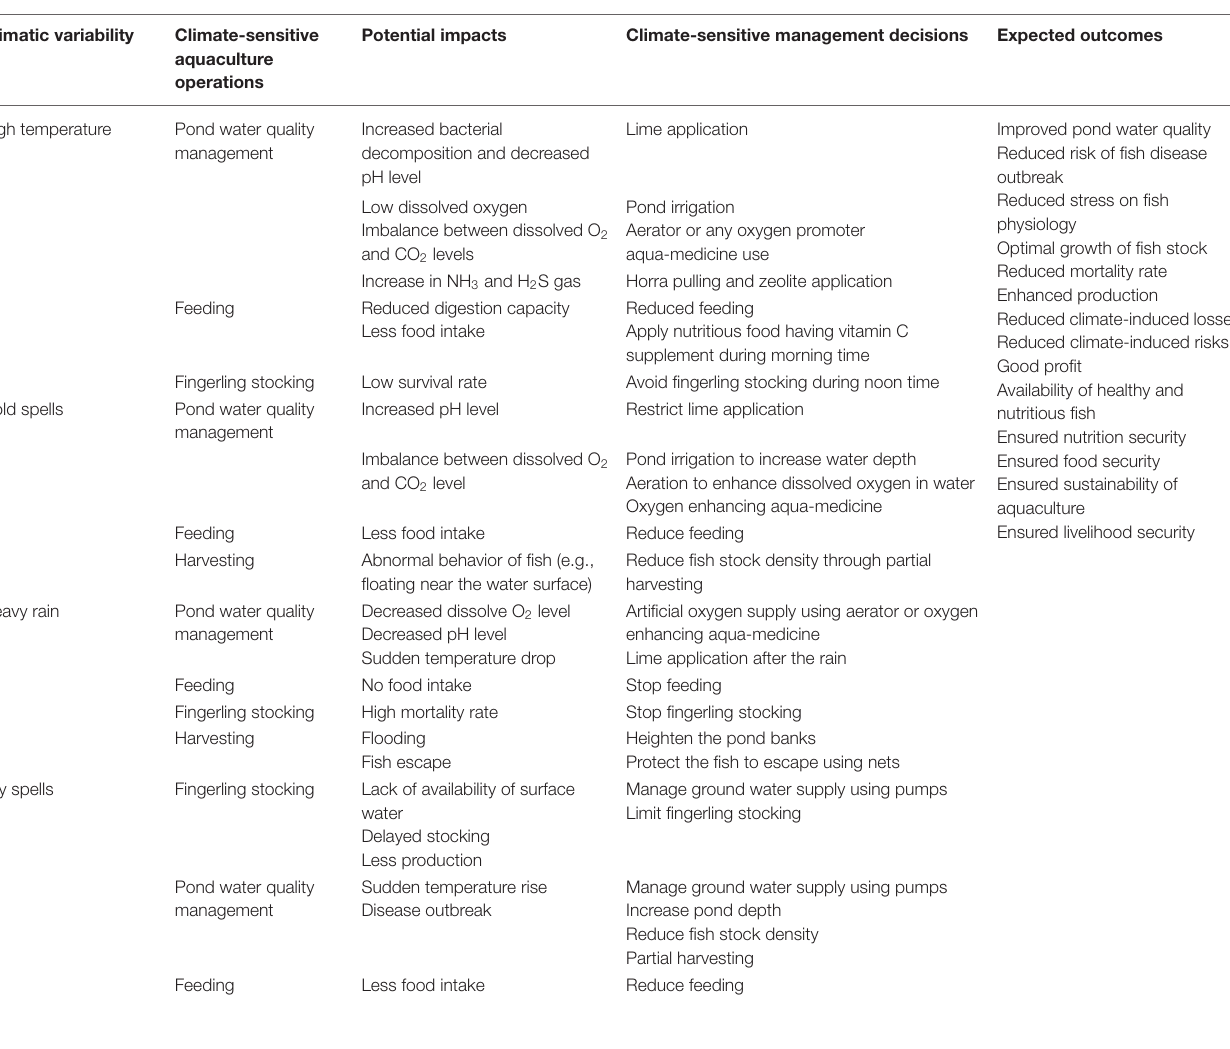
TABLE 3 | Potential impacts of climate variability on aquaculture operations, potential management responses, and their intended effects, as described by the key informants. Climatic